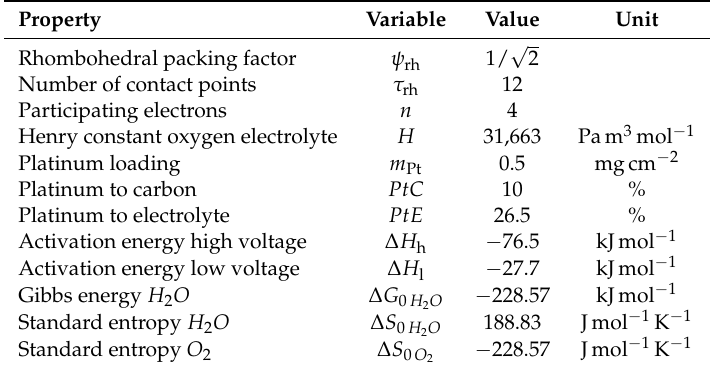
Table A4. Agglomerate model parameters used in the final simulation